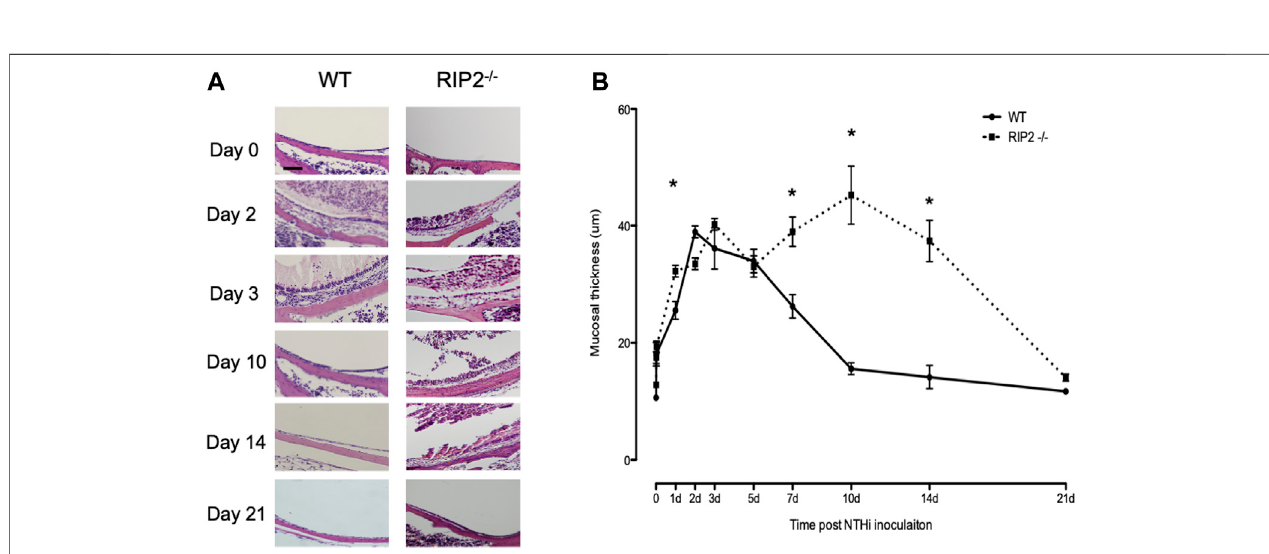
FIGURE 5 | ME responseto non-typeable H. in fl uenzae (NTHi) in C57BL/6 mice and RIP2 -/- mice up to 21 days post inoculation. (A) The MEs cavities of C57BL/6 micewere fi lledwithin fl ammatorycellsandtransudate fl uidatday2.RIP2 -/- micehadfewerin fl ammatorycellsevidentintheMEcavity.Startingatday5,noin fl ammatory cells were evident in the ME cavity of C57BL/6 mice and the mucosal layer had remodeled to its baseline appearance. Meanwhile, the MEs of RIP2 -/- mice showed a persistent in fl ammatory cell in fi ltrate and increased mucosal thickness compared with C57BL/6 mice. (B) A quantitative evaluation of mucosal thickness of the ME cavity throughout the course of OM. The MEs of C57BL/6 mice and RIP2 -/- mice showed similar degrees of mucosal thickness through 12 h after infection with non- typeable H. in fl uenzae (NTHi). Thicker mucosal was evident on day 1 for RIP2 -/- mice and day 2 for C57BL/6 mice. The degrees of thickness diverged after day 5, when the ME mucosa of RIP2 -/- mice kept persistently thick while those of C57BL/6 mice returned to near baseline thickness. Scale bar = 40 μ m. All panels are at the same magni fi cation per scale bar provided.